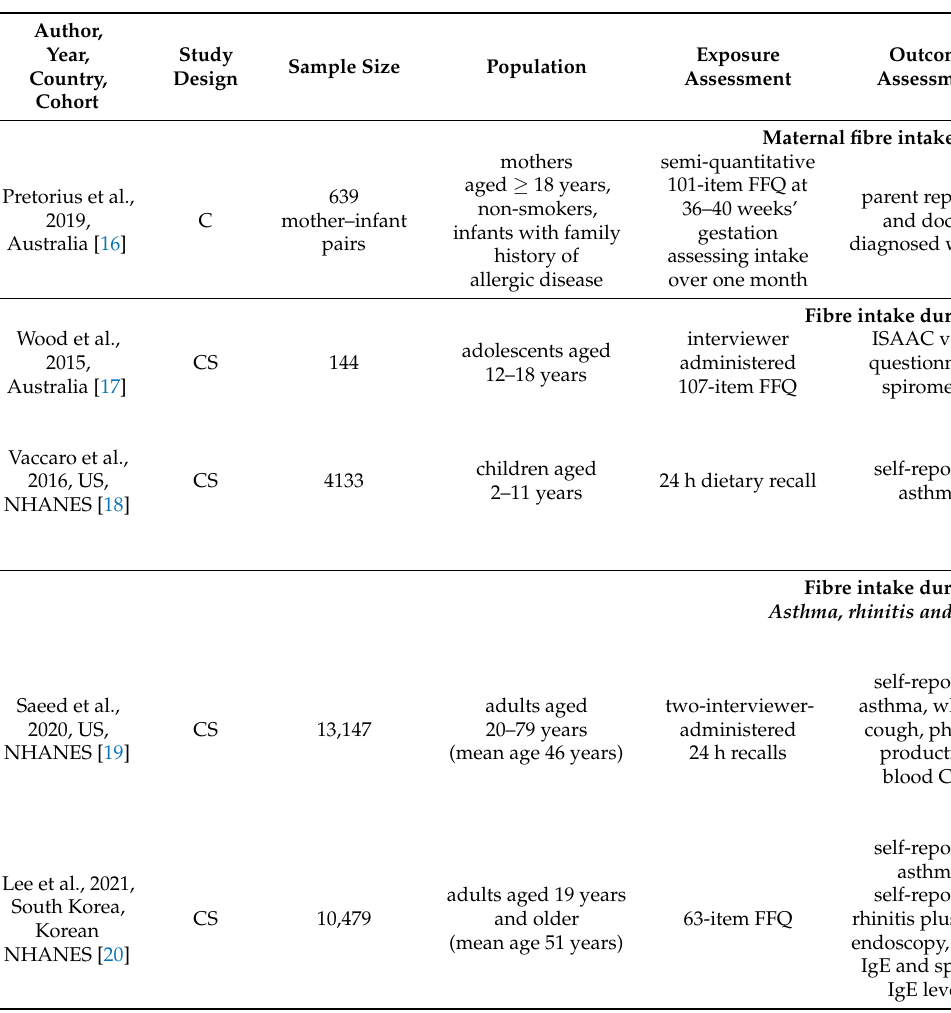
Table 1. Characteristics of the studies examining the association between dietary fibre intake and asthma, rhinitis, COPD, and lung